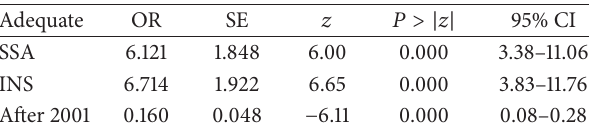
Table 2: Logit model for adequate prescriptions by subsystem and periods of